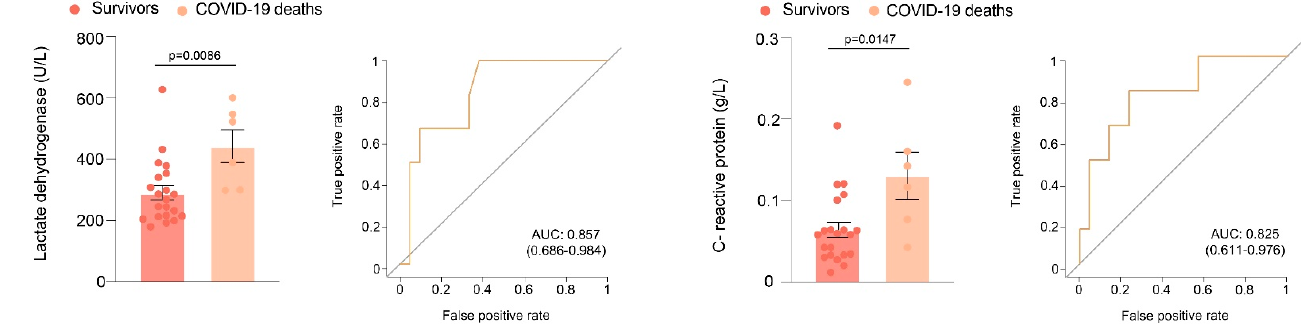
Figure 4. Lactate dehydrogenase (LDH) and C-reactive protein (CRP) levels and receiver operating characteristics plots in patients who died and those who did not.